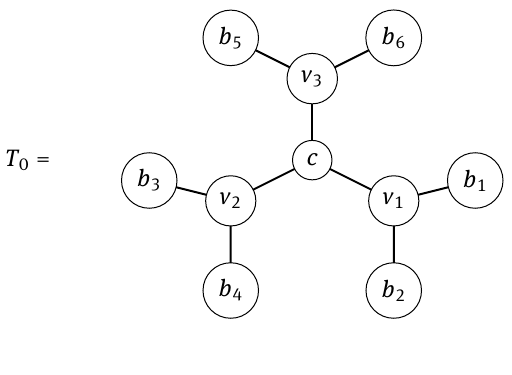
Figure 1: Diameter 5